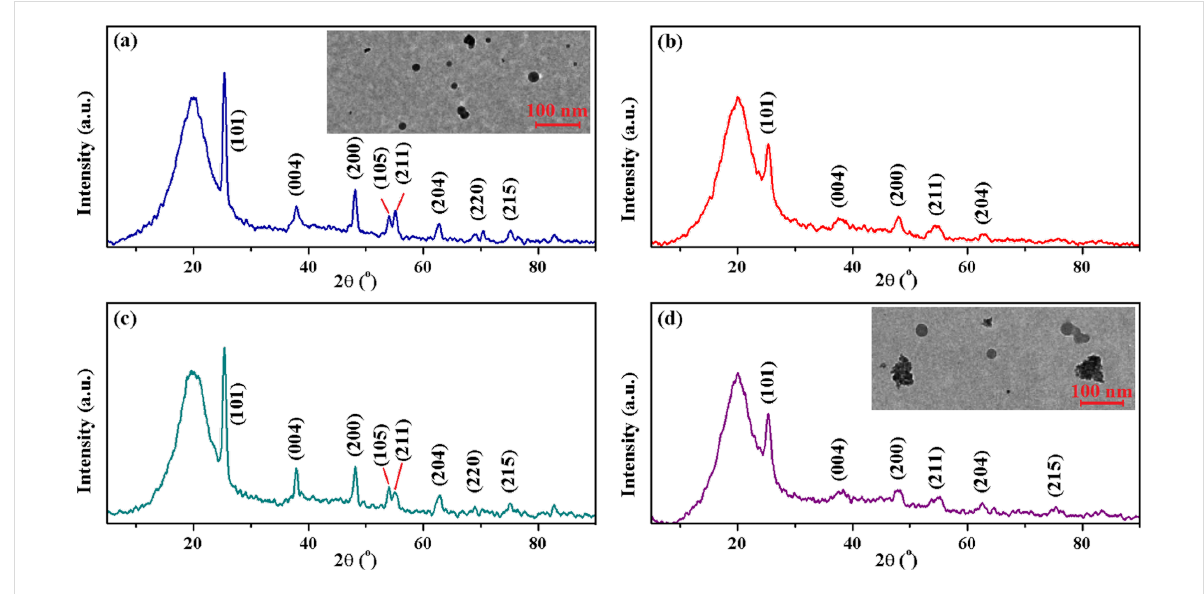
Figure 4: XRD patterns and TEM images (inset) for (a) S1, (b) S2, (c) S3 and (d) S4 hybrids.